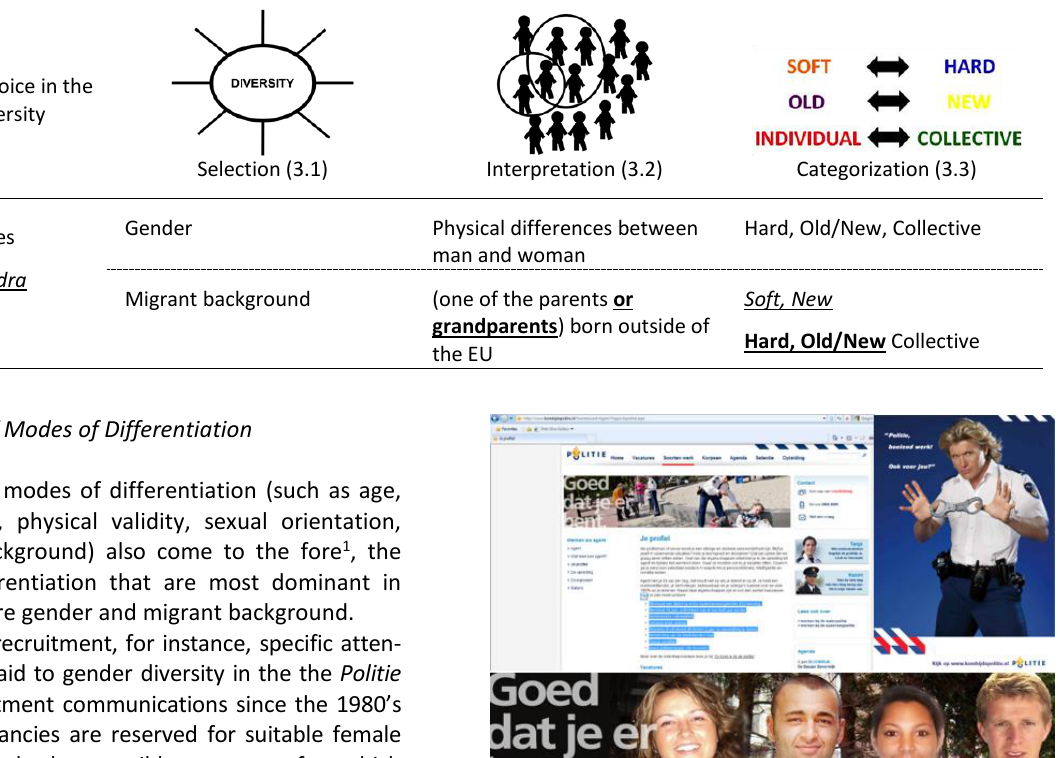
Table 2. Similarities and Differences in Definitions of Diversity (Mossos d’Esquadra, Politie Utrecht).